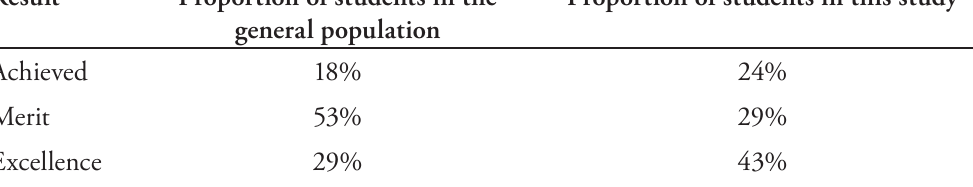
Table 2. NCEA Results of Students Who Achieved NCEA in 2018 Result Proportion of students in